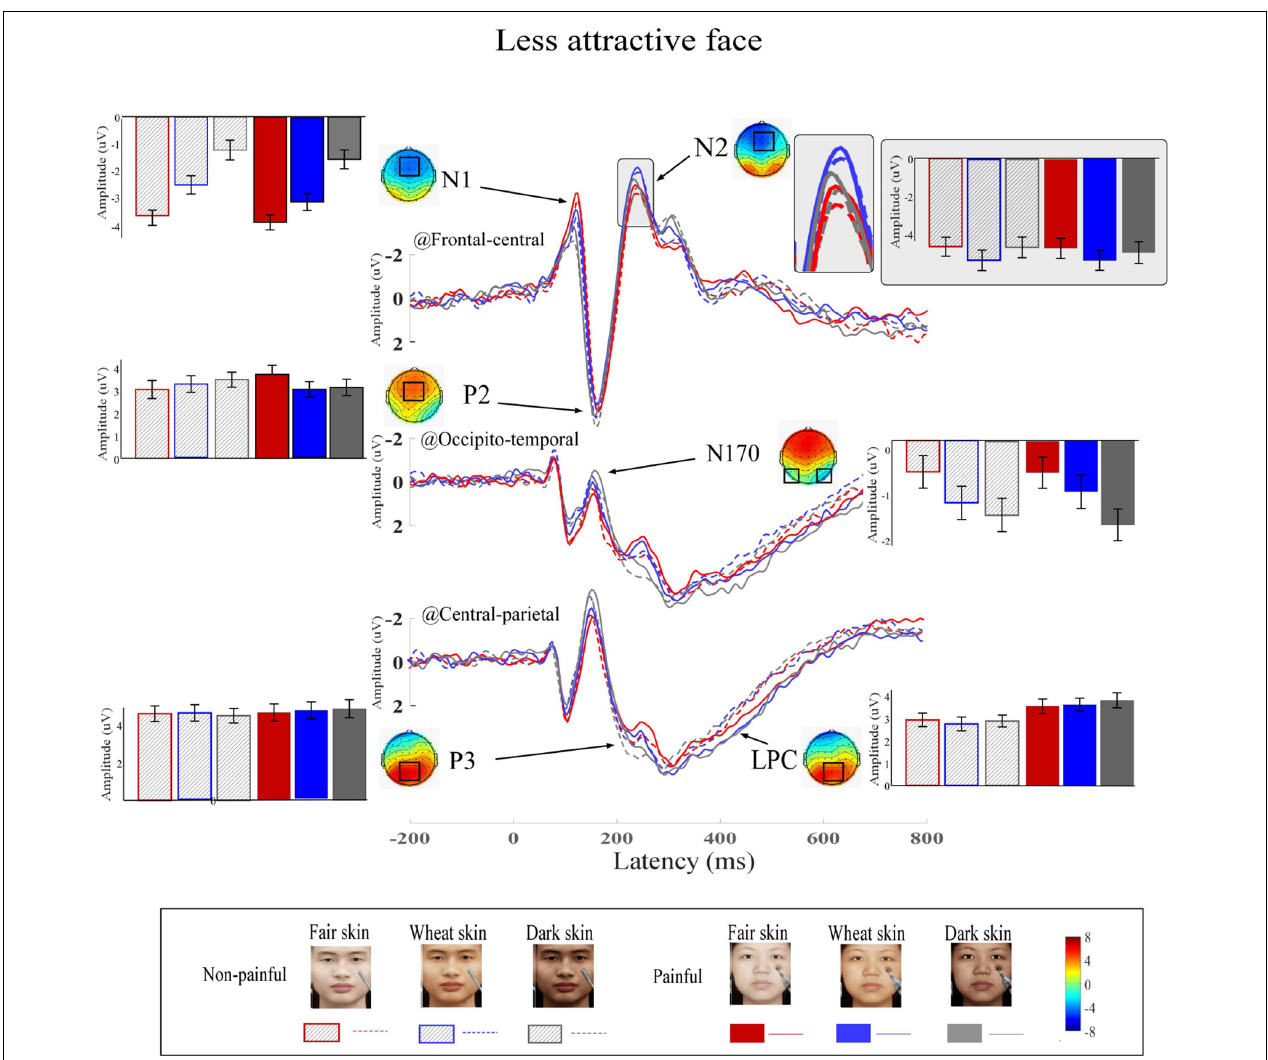
FIGURE 5 | Event-related potential (ERP) waveforms and scalp topography distributions to less attractive faces. ERP waveforms, bar charts, and scalp topographies elicited by the less attractive faces with fair (red), wheat (blue), and dark (gray) skin. These pictures had either non-painful (linear) or painful (solid) cues. Electrodes used to estimate ERP amplitudes are marked by black squares on their respective topographic distributions. Data in the bar charts are ERP amplitudes expressed as means ± standard error of the